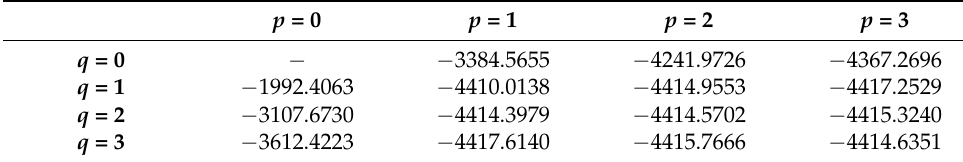
Table A8. AIC values of z -axis raw data at each order.